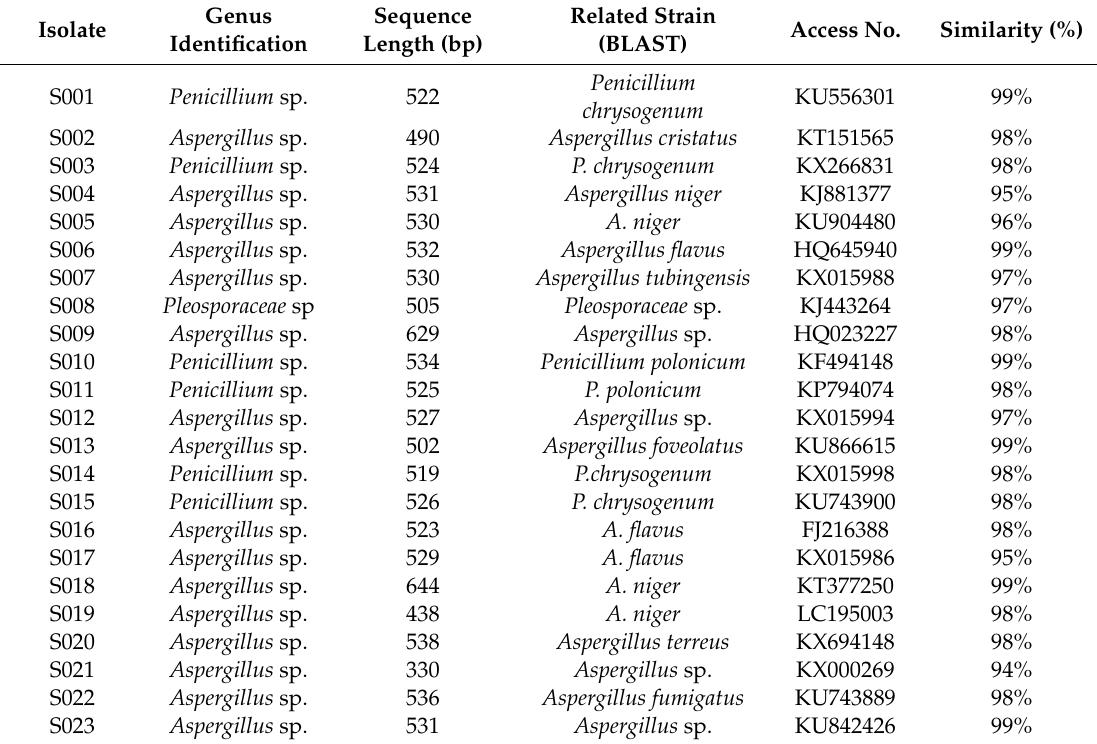
Table 3. Identification of the isolated fungal strains (S001–S023). The closest relatives to fungal strains according to a BLAST search are